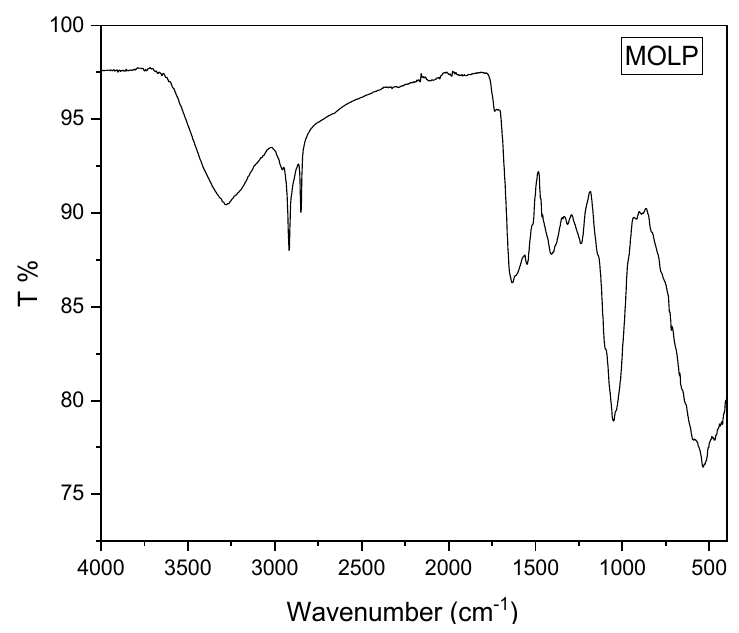
Figure 8. FTIR spectrum of Moringa oleifera leaf powder (MOLP). Table 3. Functional groups from the FTIR spectra of MOLP, PEG, and solid dispersions 1